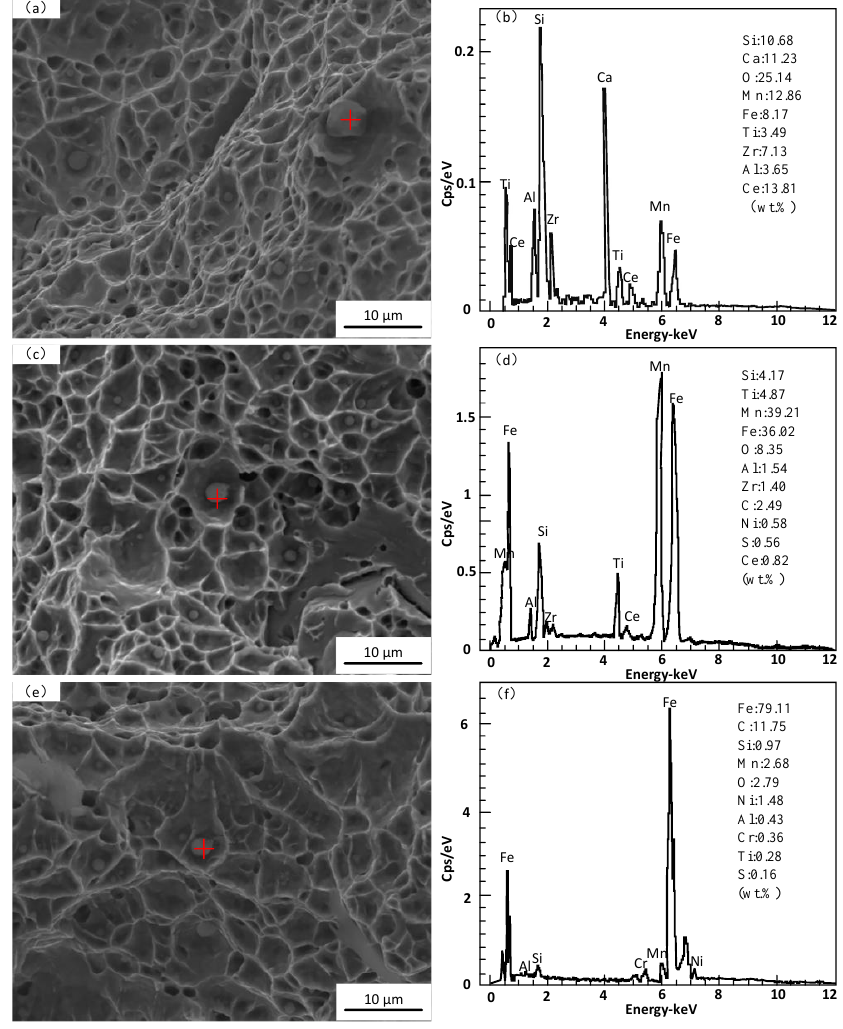
Figure 4. SEM images of fibrous zones on fracture surfaces and EDS spectrums of inclusions in deposited metal under different heat inputs: ( a , b ) 1.45 kJ/mm; ( c , d ) 1.78 kJ/mm; ( e , f ) 2.31 kJ/mm.